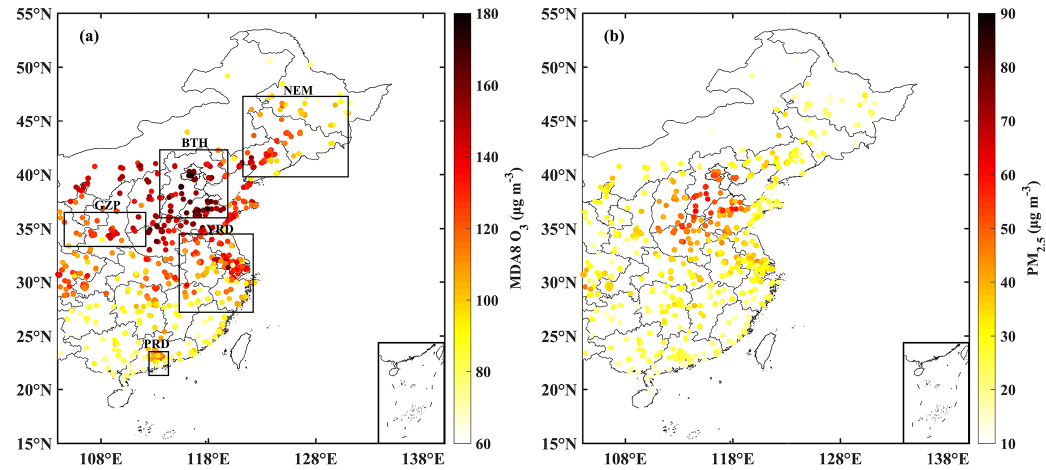
Figure 1. Average concentration of MDA8 O 3 (a) and PM 2 . 5 (b) in eastern China during the summers of 2015–2018. Stations and key urban clusters (black boxes) are shown in (a)